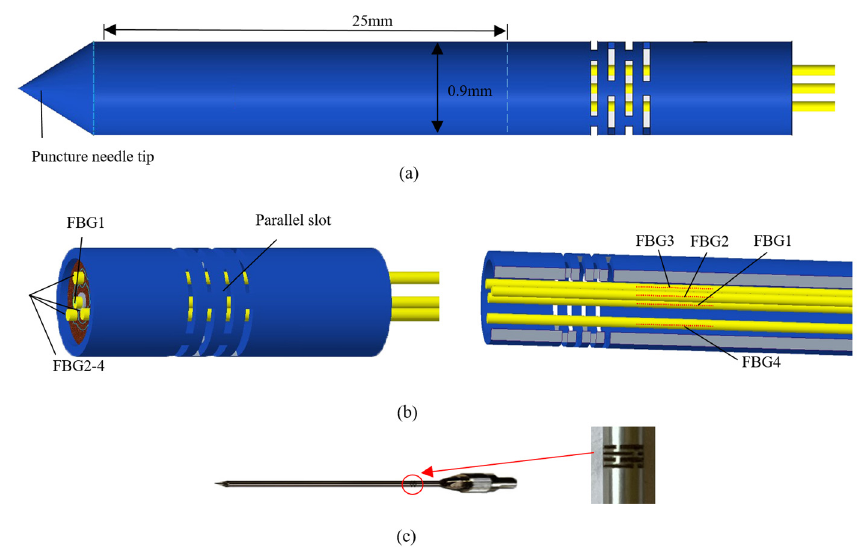
Figure 2. Three-dimensional force FBG sensor structure diagram. ( a ) Structure and assembly overview; ( b ) cross-section; ( c ) prototype.